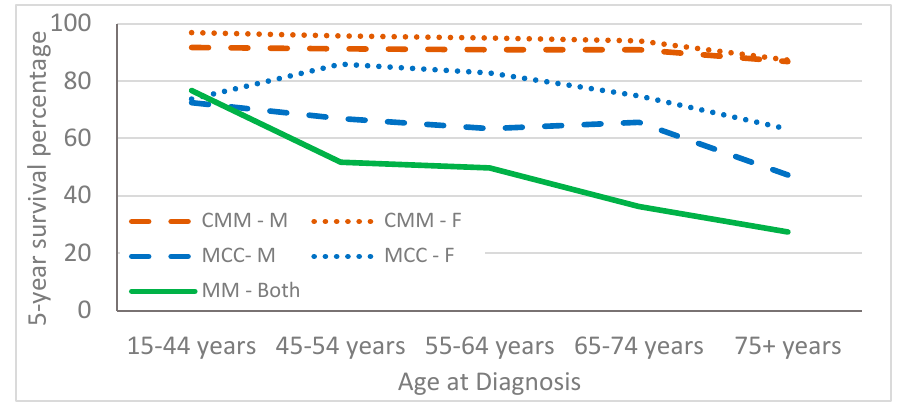
Figure 3. Relative survival by age for people with cutaneous malignant melanoma (CMM), Merkel cell carcinoma (MCC) and mucosal melanoma (MM) in 17 cancer registries in SEER 2000–2019.